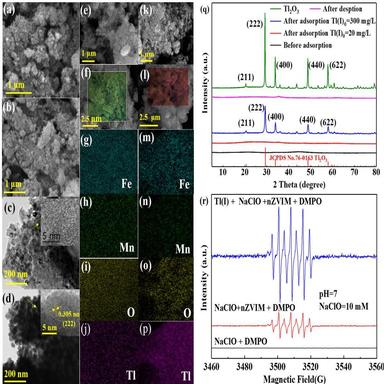
The (a) original and (b) regenerated nZVIM; the HRTEM images of (c) nZVIM adsorbed with Tl(I)0 = 20 mg/L and (d) nZVIM adsorbed with Tl(I)0 = 300 mg/ L; the SEM-EDS elemental mapping images of (e–j) nZVIM adsorbed with Tl(I)0 = 20 mg/L and (k–p) nZVIM adsorbed with Tl(I)0 = 300 mg/L; (q) the XRD patterns of the original, adsorbed and regenerated nZVIM; and (r) NaClO-based ESR spectra obtained using DMPO as spin trapping agent with/without nZVIM and Tl(I) (NaClO dosage = 10 mmol/L, temperature = 298 K, and r